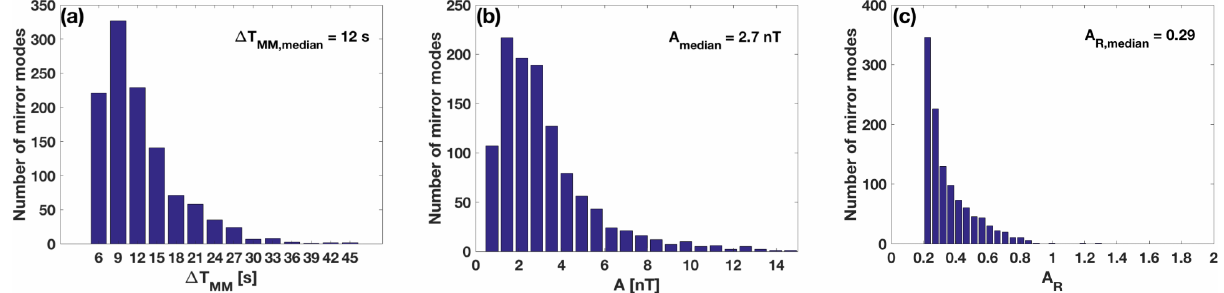
Figure 5. Statistics of the properties of MMs in ICME-driven sheath regions. (a) The distribution of detected mirror modes (MMs) according to their duration ( (cid:49)T MM ) and in 3s bins. (b) MM occurrence as a function of their amplitude ( A ) in 0.7nT bins. (c) MM occurrence as a function of the relative amplitude of a structure ( A R ) in 0.04 bins. We have checked that the distributions are not biased due to the sheaths containing a large number of